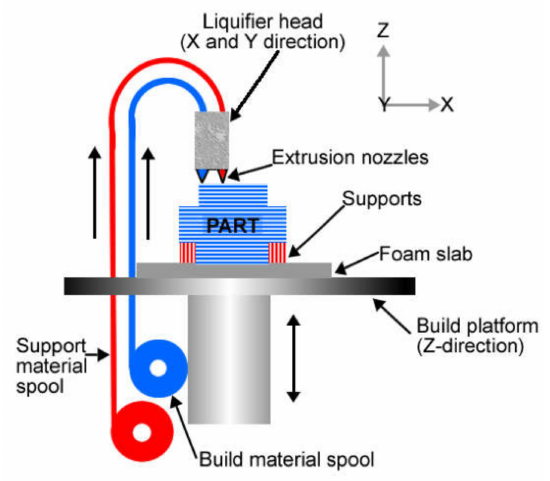
Figure 3. Schematic of material extrusion process [32]; published under the open access Creative Commons license with MDPI.